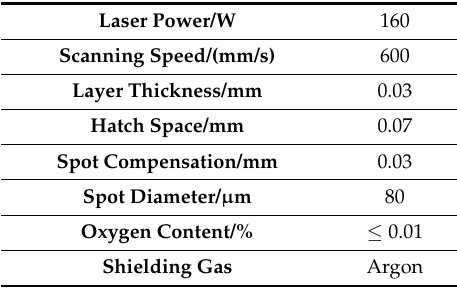
Table 2. SLM processing parameters of 316L steel powder.